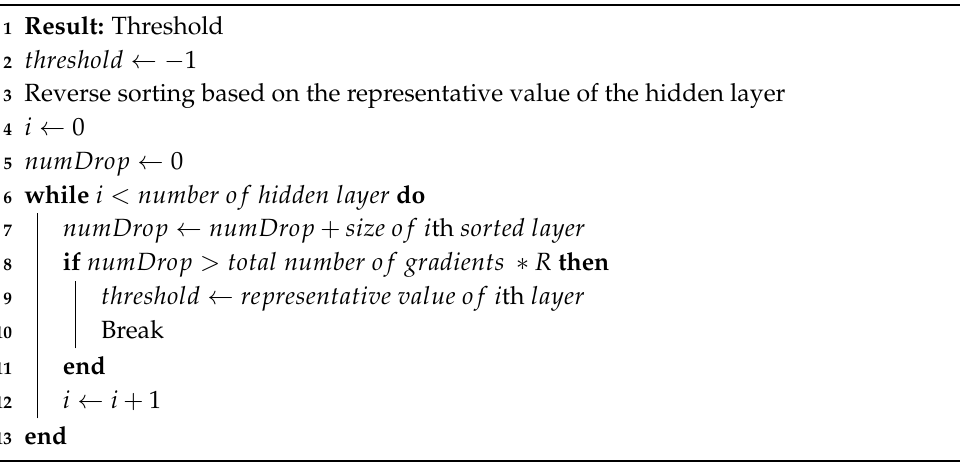
Algorithm 1 Threshold searching